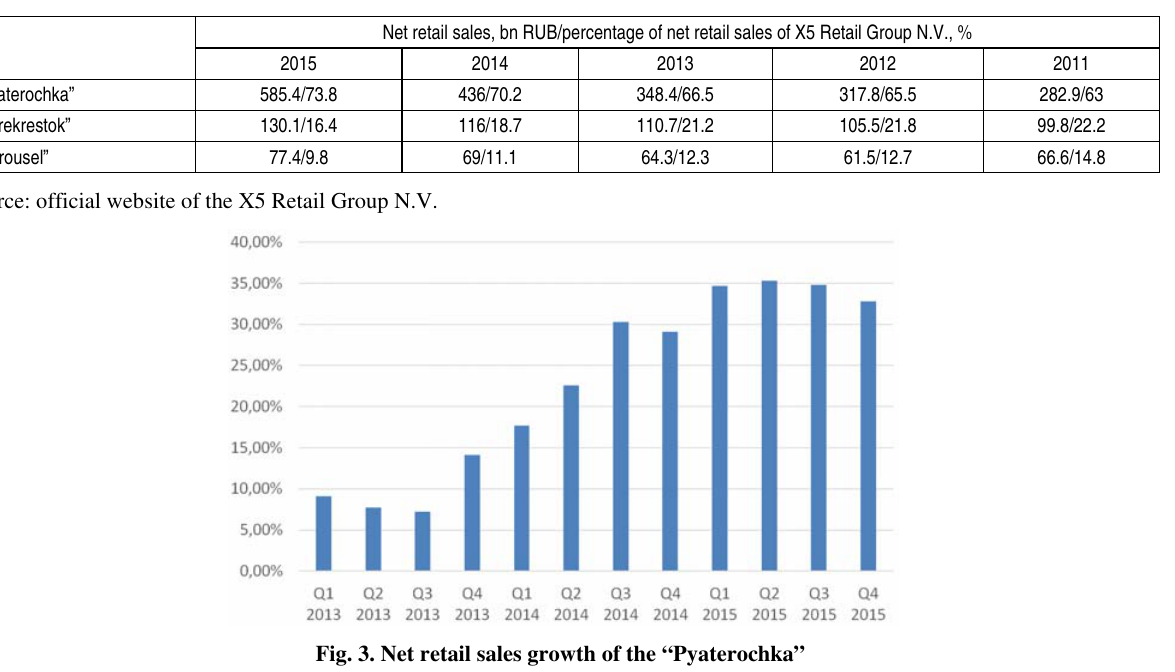
Table 1. Performance indicators (2011-2015)